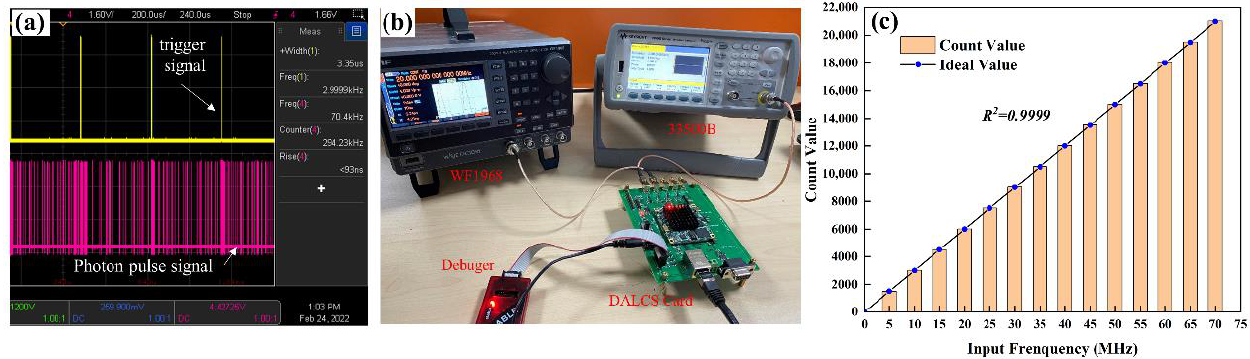
Figure 10. Signal test: ( a ) Laser and PMT module output signal; ( b ) Test environment; ( c ) Count